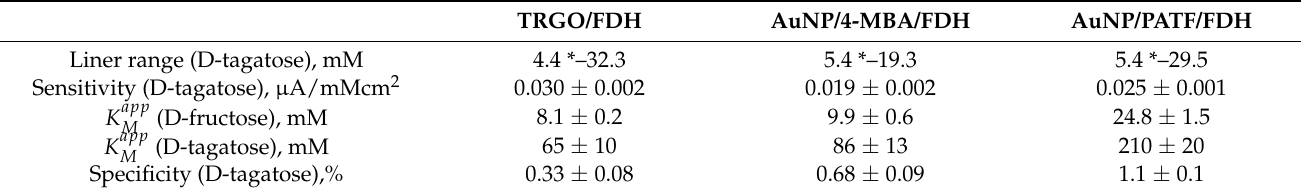
Table 1. Main parameters of bioelectrocatalytic oxidation of D-tagatose and D-fructose using proposed biosensors.